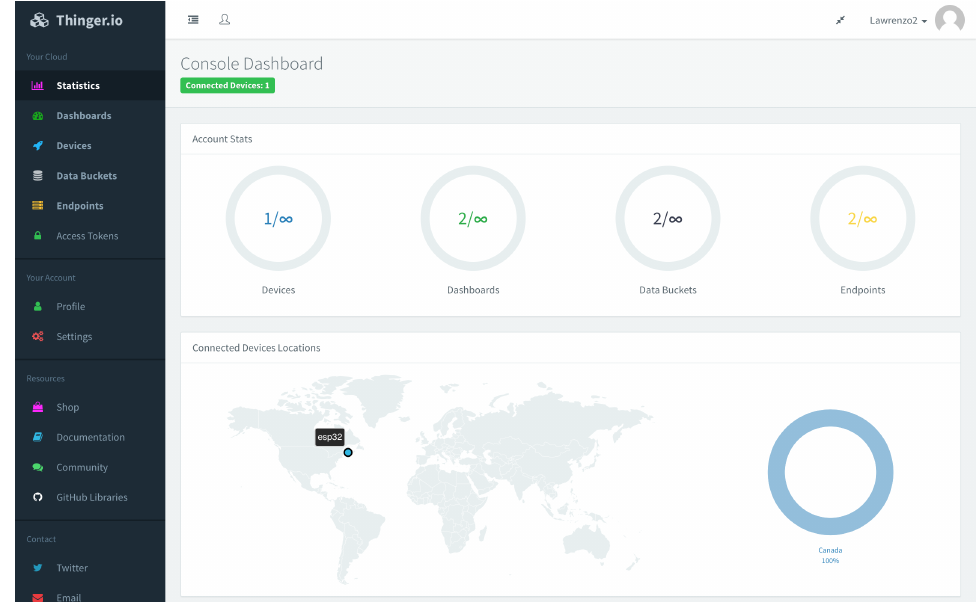
Figure 7. Thinger.IO Console